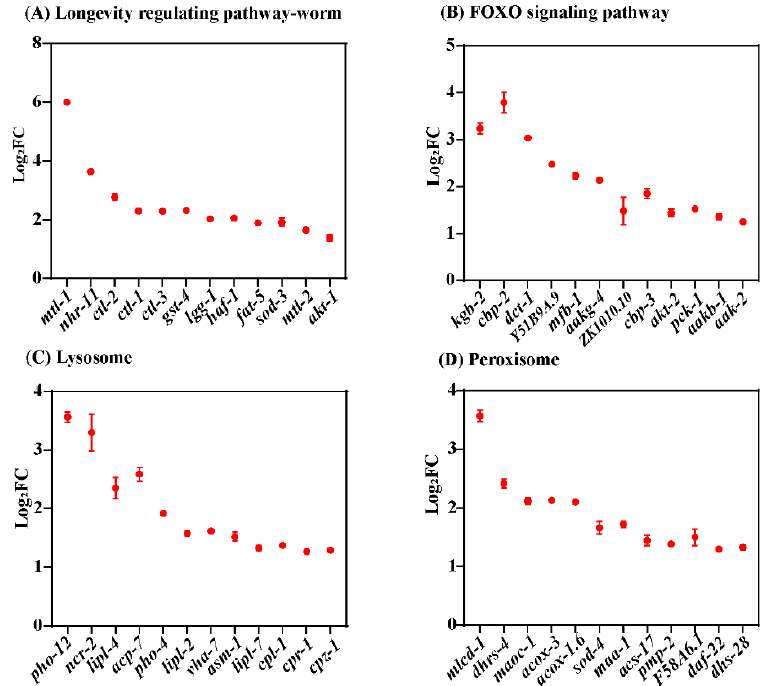
Figure 4. The expression of up-regulated pathway related genes of C. elegans on CeMM. ( A ) Longevity-regulating pathway-related genes in C. elegans . ( B ) FOXO signaling pathway-related genes in C. elegans . ( C ) Lysosome-related genes in C. elegans . ( D ) Peroxisome-related genes in C. elegans . Log2FC: Log2(Fold Change). All data shown here are mean ± SEM.